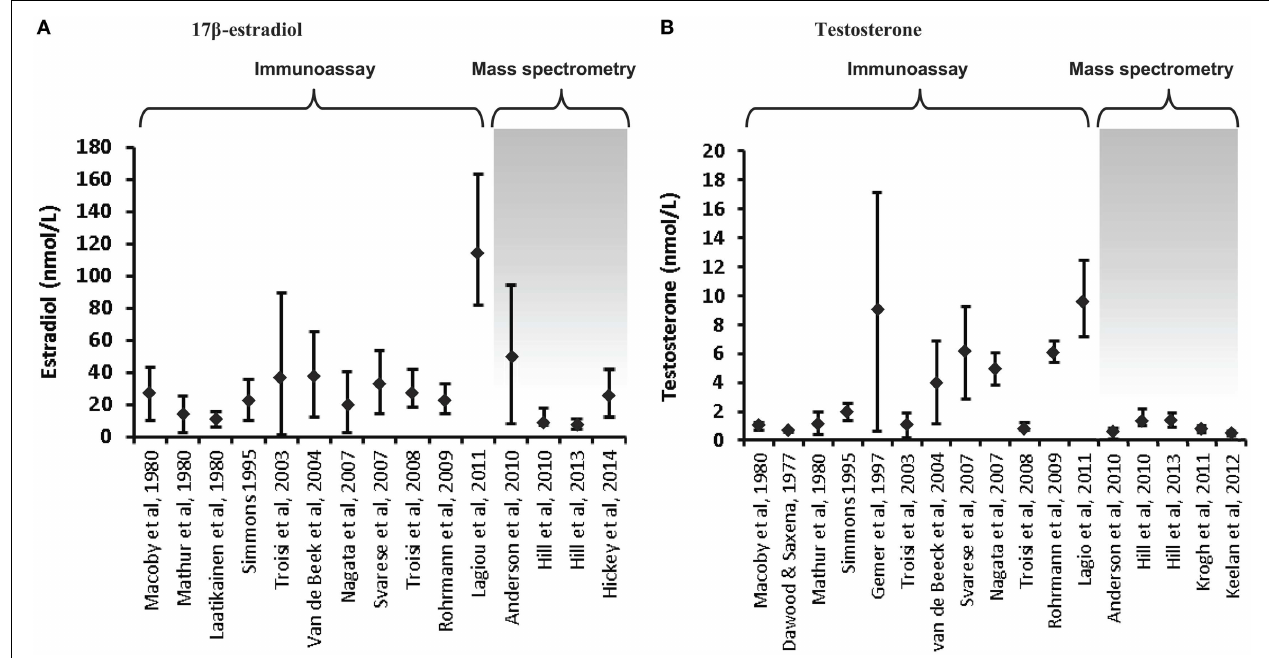
male/female samples). Of the 17 studies included, the final 5 employed mass spectrometry.The last study displayed on each chart has the largest samples size ( n = 860) and extensive assay validation for cord blood.The steroid values from the studies by Hill et al. (41) are the mean of the published umbilical artery and vein values.The figure demonstrates the influence of assay characteristics on sex steroid values, although the lack of assay specificity is much more significant for measurement of testosterone compared to